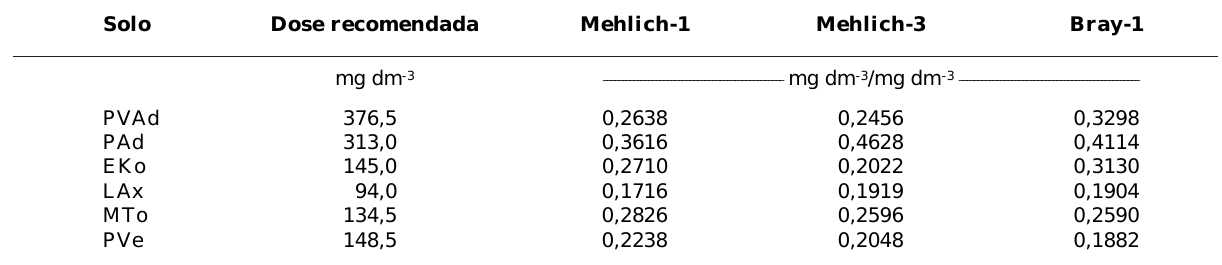
Quadro 7. Doses de fósforo recomendadas para 90 % da produção máxima em B. brizantha no primeiro corte e taxas de recuperação do fósforo aplicado aos solos pelos extratores Mehlich-1, Mehlich-3 e Bray-1